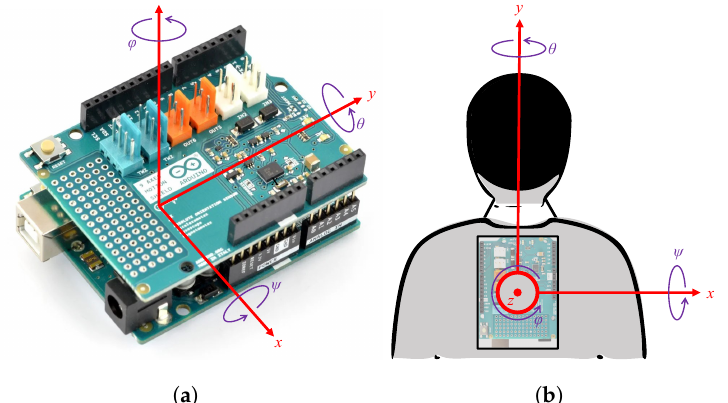
Figure 7. The back-controller’s linear and rotational coordinate system conventions: ( a ) In relative to the Arduino UNO R3 and 9-axis motion shield, ( b ) In relation to the user when the controller placed on their back. The arrows indicates the direction of positive signs for each